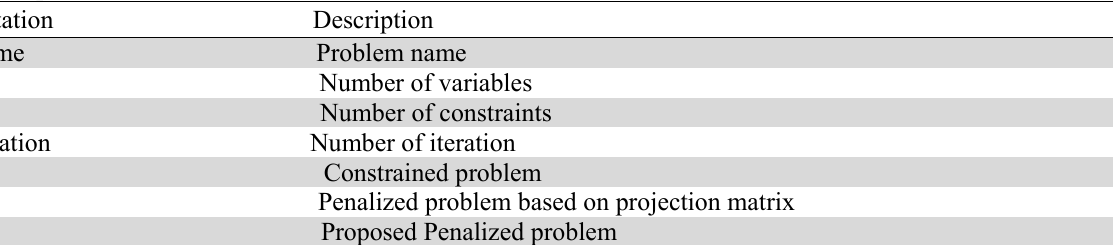
Description of the notations used in Table